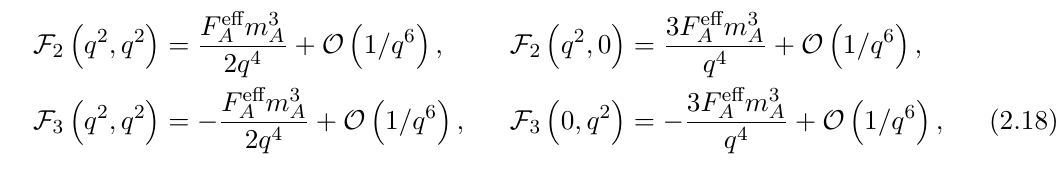
= 0 , q 2 = q 2 , and q 2 = 0 , respectively. 1 1 2 2